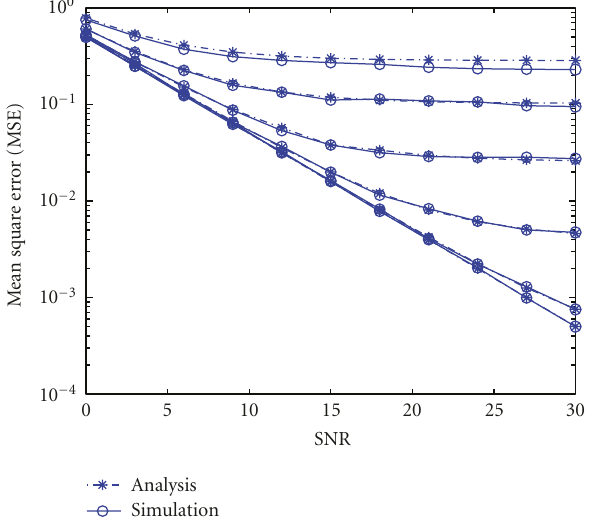
Figure 3: Analytical and experimental plots of MSE in the chan- nel estimates for di ff erent values of ROE; σ 2 (2 π/ 100) 2 ,(2 π/ 250) 2 ,(2 π/ 1000) 2 ,0 from uppermost to downmost,